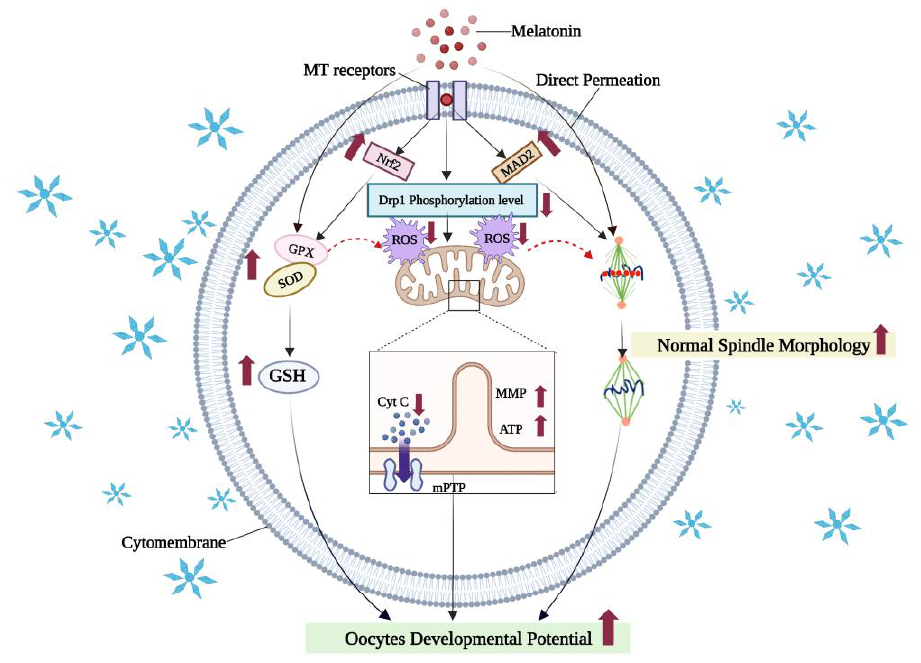
Figure 4. The mechanism of melatonin in reducing oxidative damages in vitrified oocytes. Melato- nin can enter oocytes through receptors, act on the Nrf2 antioxidant signaling pathway, and enhance the expression of antioxidant enzymes, protect normal morphology and function of organelles such as mitochondria and the spindle, and ensure the correct segregation of meiotic chromosomes. Mel- atonin can also directly penetrate into cells to scavenge free radicals, reduce intracellular ROS, and improve the development potential of cells in vitro. Created with BioRender.com (accessed on 19 October, 2022).